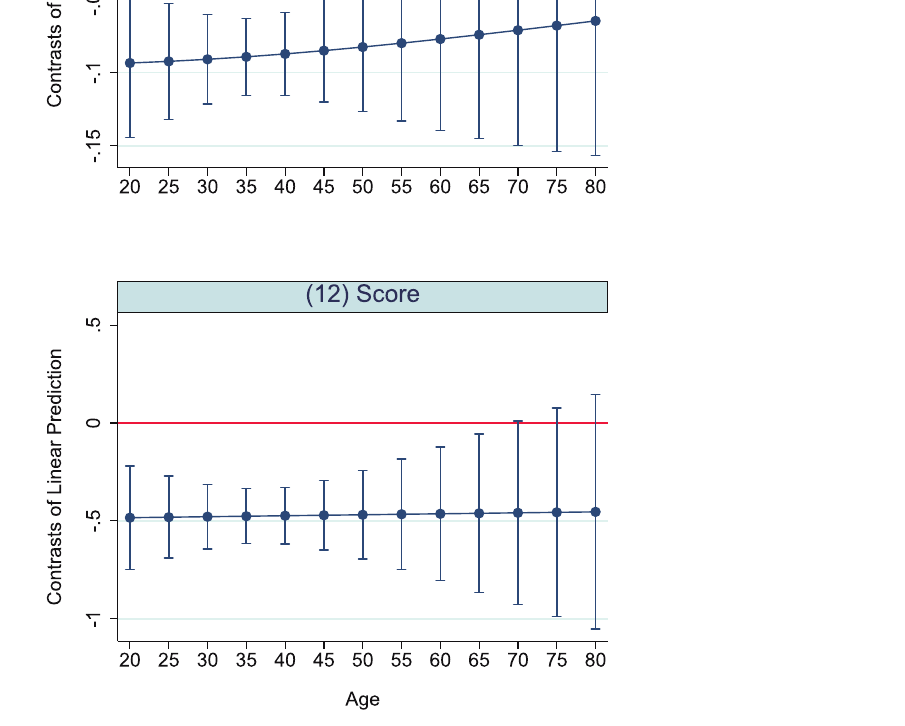
Fig 4. Contrast of predictions. Sex and age interactions.